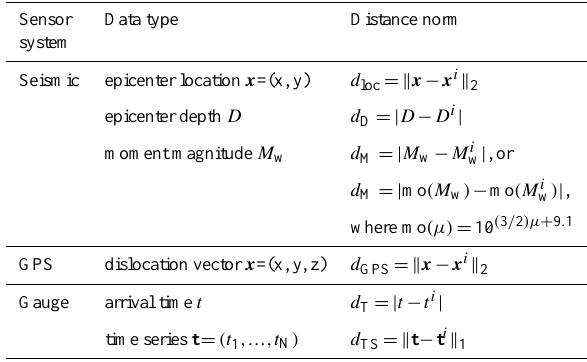
Table 2. Data types, sensor systems and individual norms in the GITEWS system. Indexed values represent scenario